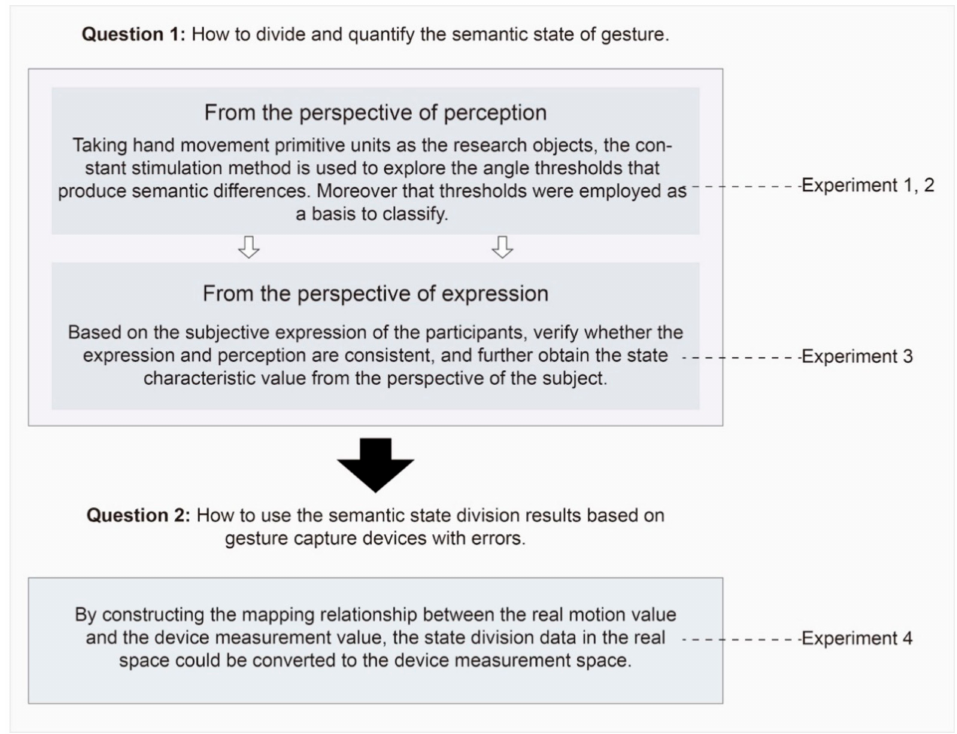
Figure 3. Experimental design framework